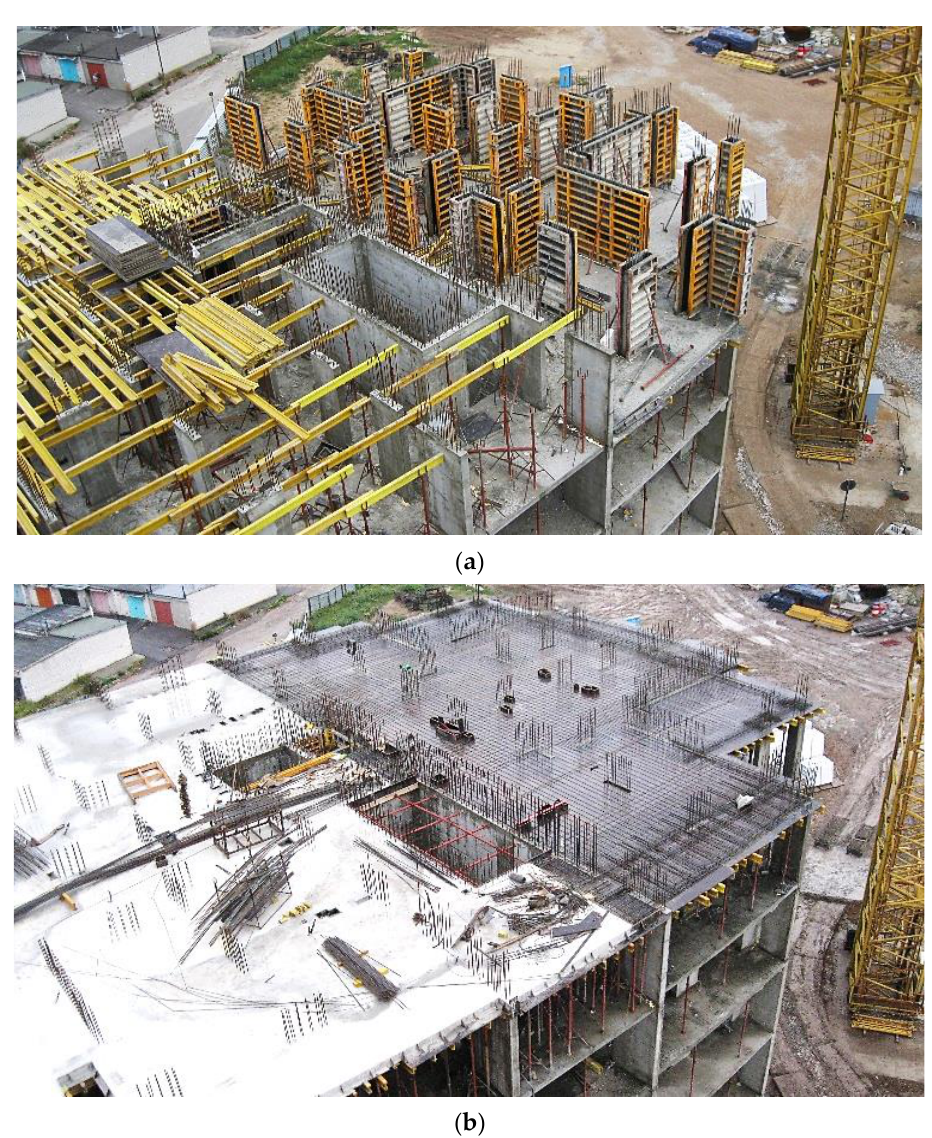
Figure 8. Work performance broken down into task areas: ( a ) I — floor formwork installation; II — concreting of columns, walls; ( b ) I — floor slab concrete curing; II — slab reinforcement.